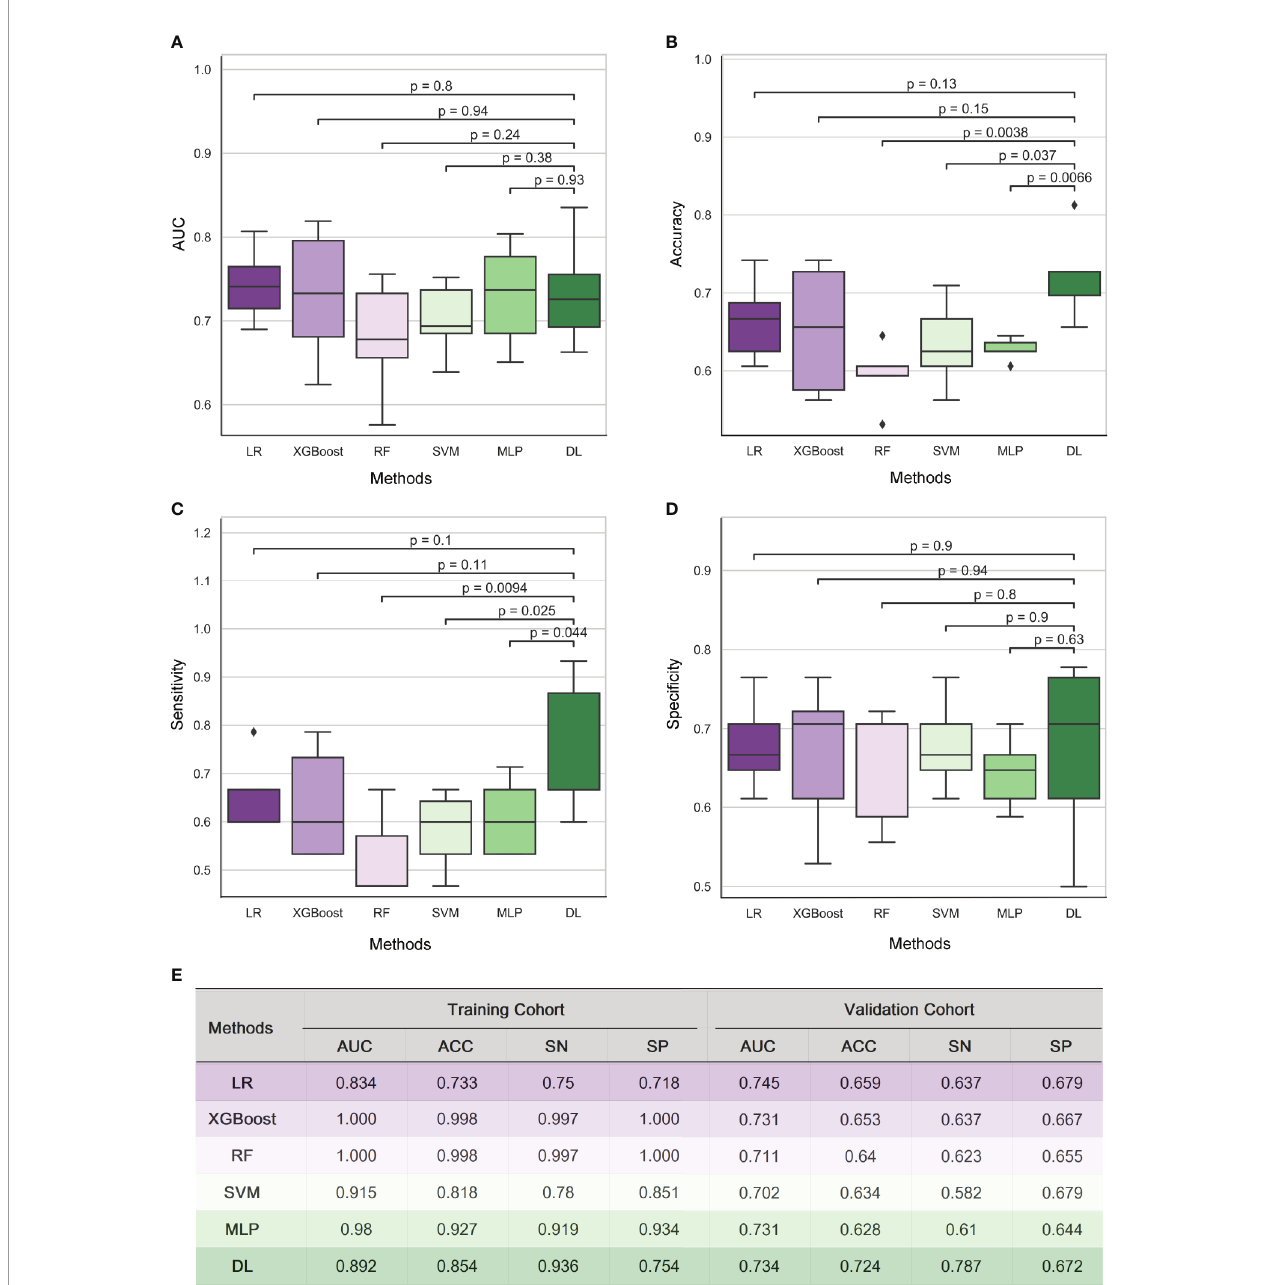
FIGURE 2 | Results of Radiomic analysis and 3D DenseNet deep learning model for detecting MG in a cohort of 182 thymoma patients. The performance of fi ve radiomic models and 3D-DenseNet-DL model was compared using Area Under ROC Curve (AUC) (A) , accuracy (B) , sensitivity (C) , and speci fi city (D) . 3D DenseNet deep learning model for detecting MG showed similar results in AUC and speci fi city, but relatively better results in accuracy and sensitivity compared to fi ve radiomic analysis models (E) . “ RF ” , “ LR ” , and “ DL ” refer to “ Random Forest ” , “ Logistic Regression ” , and “ Deep Learning ” respectively; “ AUC ” , “ ACC ” , “ SN ” , and “ SP ” refer to the metrics Area Under ROC Curve, Accuracy, Sensitivity, and Speci fi city,